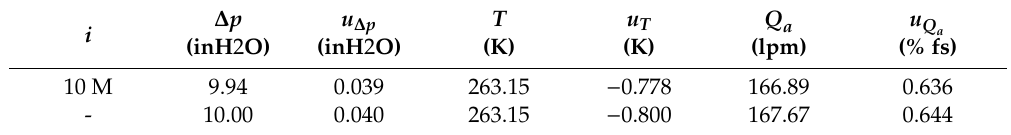
Table 10. Simulation 2: actual volumetric flow rate.